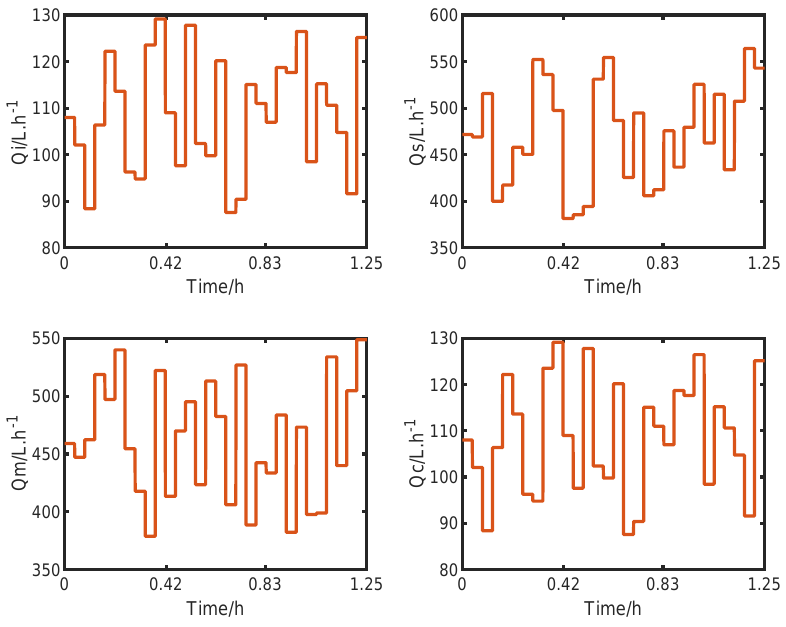
Figure 6. LHS inputs.